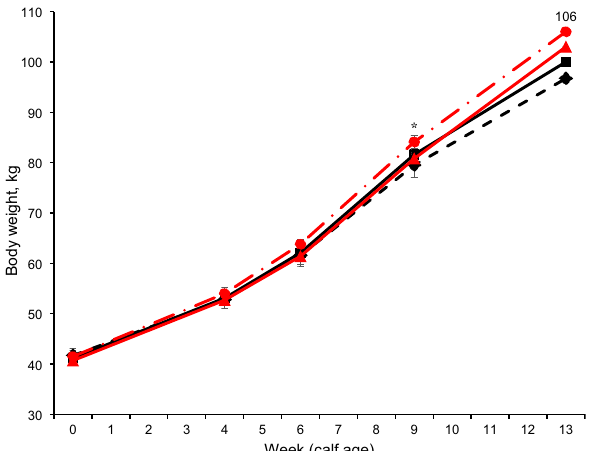
Figure 4. Body weight of calves (n = 16 calves/treatment, 8 male and 8 female) with one of the following treatments: Late grouping-late incremental hay (LG-LH; black filled square), late grouping-early incremental hay (LG-EH; black filled diamond), early grouping-late incremental hay (EG-LH; red filled triangle), and early grouping-early incremental hay (EG-EH; red filled circle) during the total period of study (from 1 to 13 wk of age). Data are presented as means ± SEM.